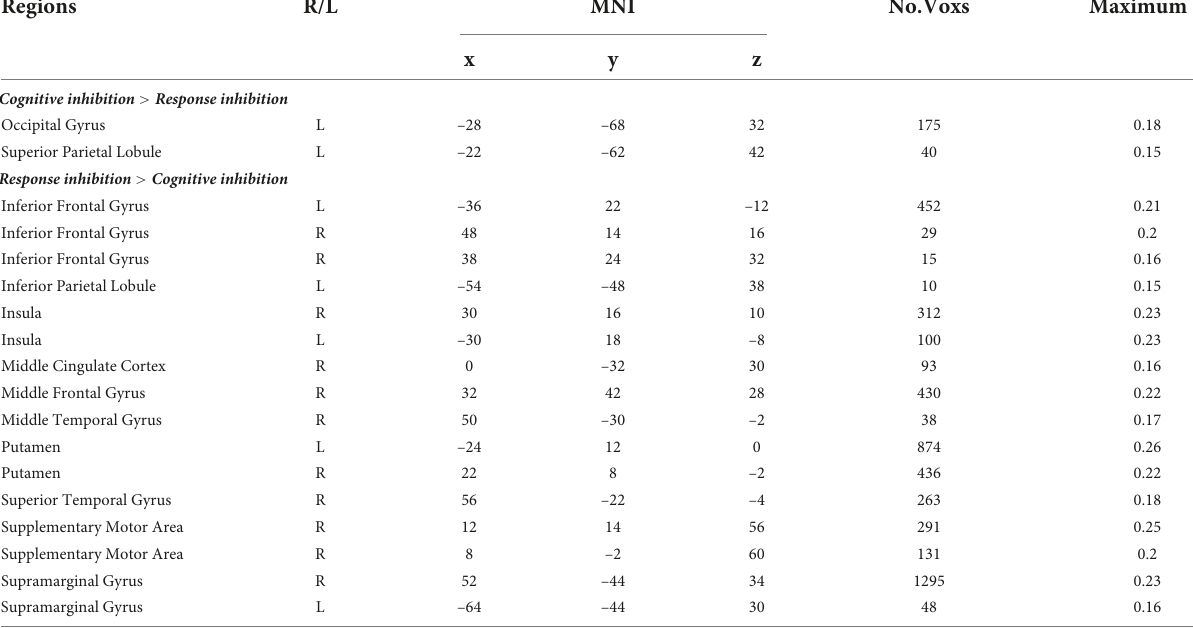
TABLE 2 Brain activation differences between cognitive inhibition and response inhibition.